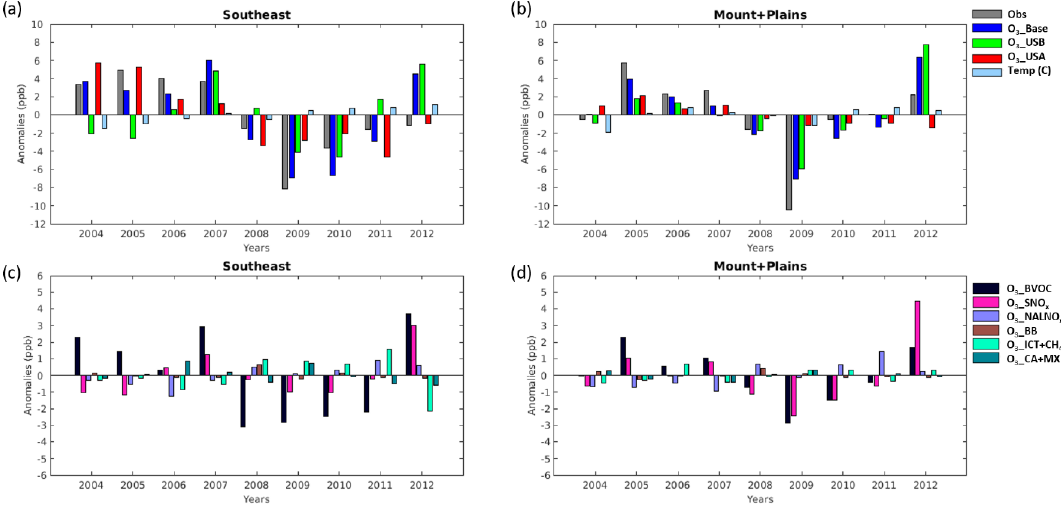
Figure 8. Anomaly on the MDA8 O 3 _top10obs_JJA days relative to the 2004–2012 average in the Southeast (a, c) and in the Mountains and Plains (b, d) regions. Panels (a, b) show the observations, O 3 _Base, O 3 _USB, O 3 _USA, and daily average temperature (in ◦ C) on O 3 _top10obs_JJA days. Panels (c, d) show O 3 _BVOC, O 3 _SNO x , O 3 _NALNO x , O 3 _BB, O 3 _ICT + CH 4 , and O 3 _CA +